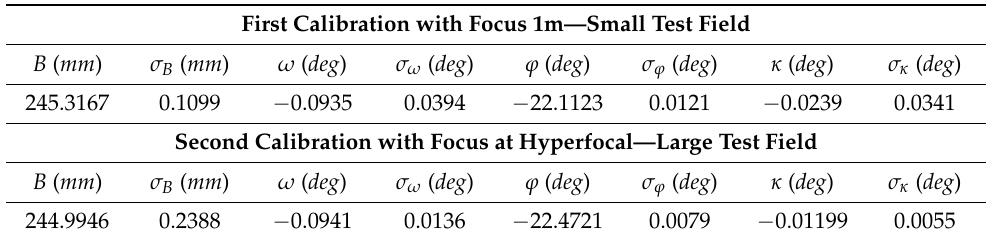
Table 2. Calibration results. Exterior parameters of the right camera with respect to the left one. First Calibration with Focus 1m—Small Test